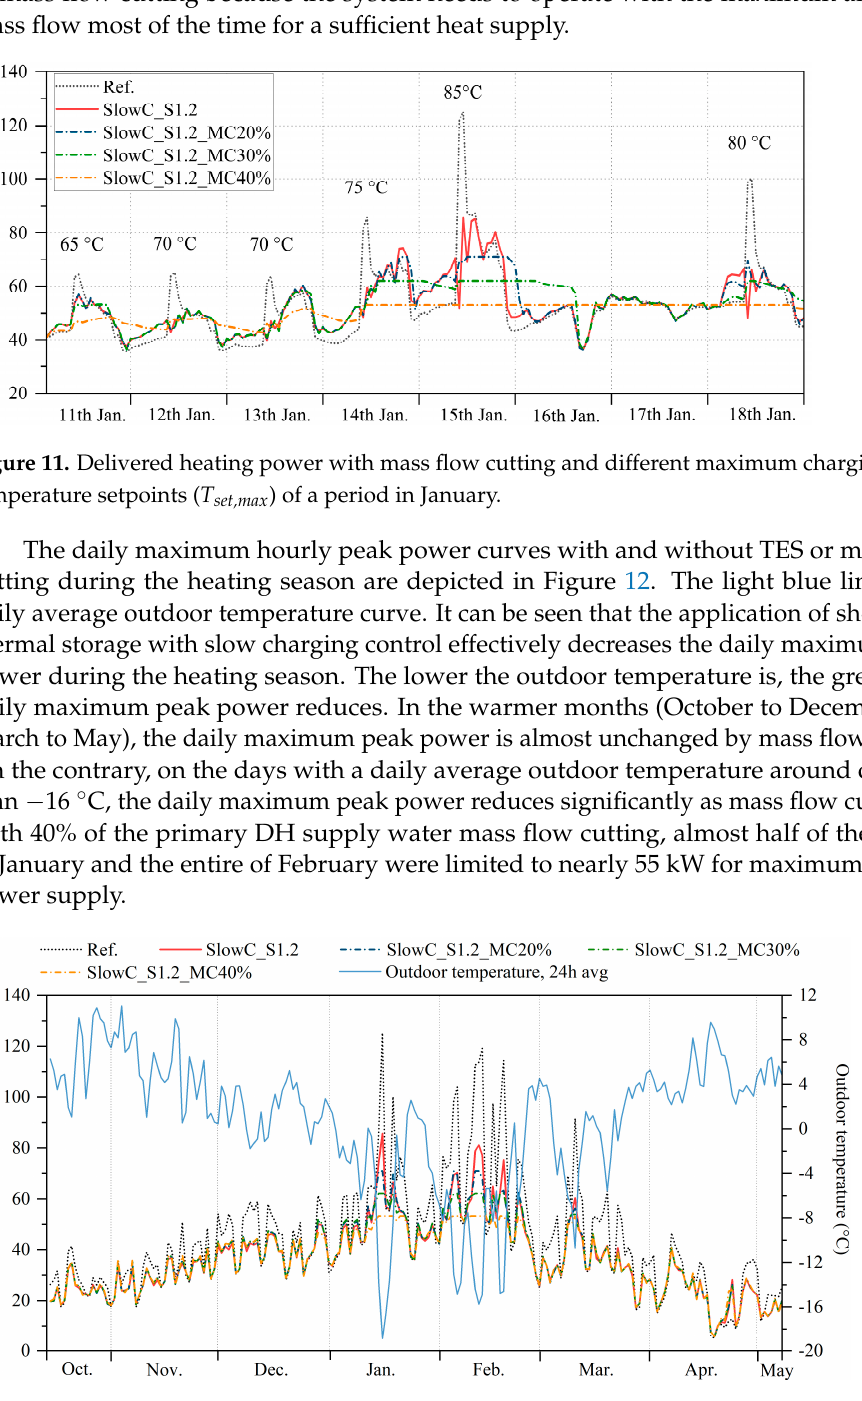
Figure 12. Heating season (14 October–7 May) daily maximum hourly peak power.